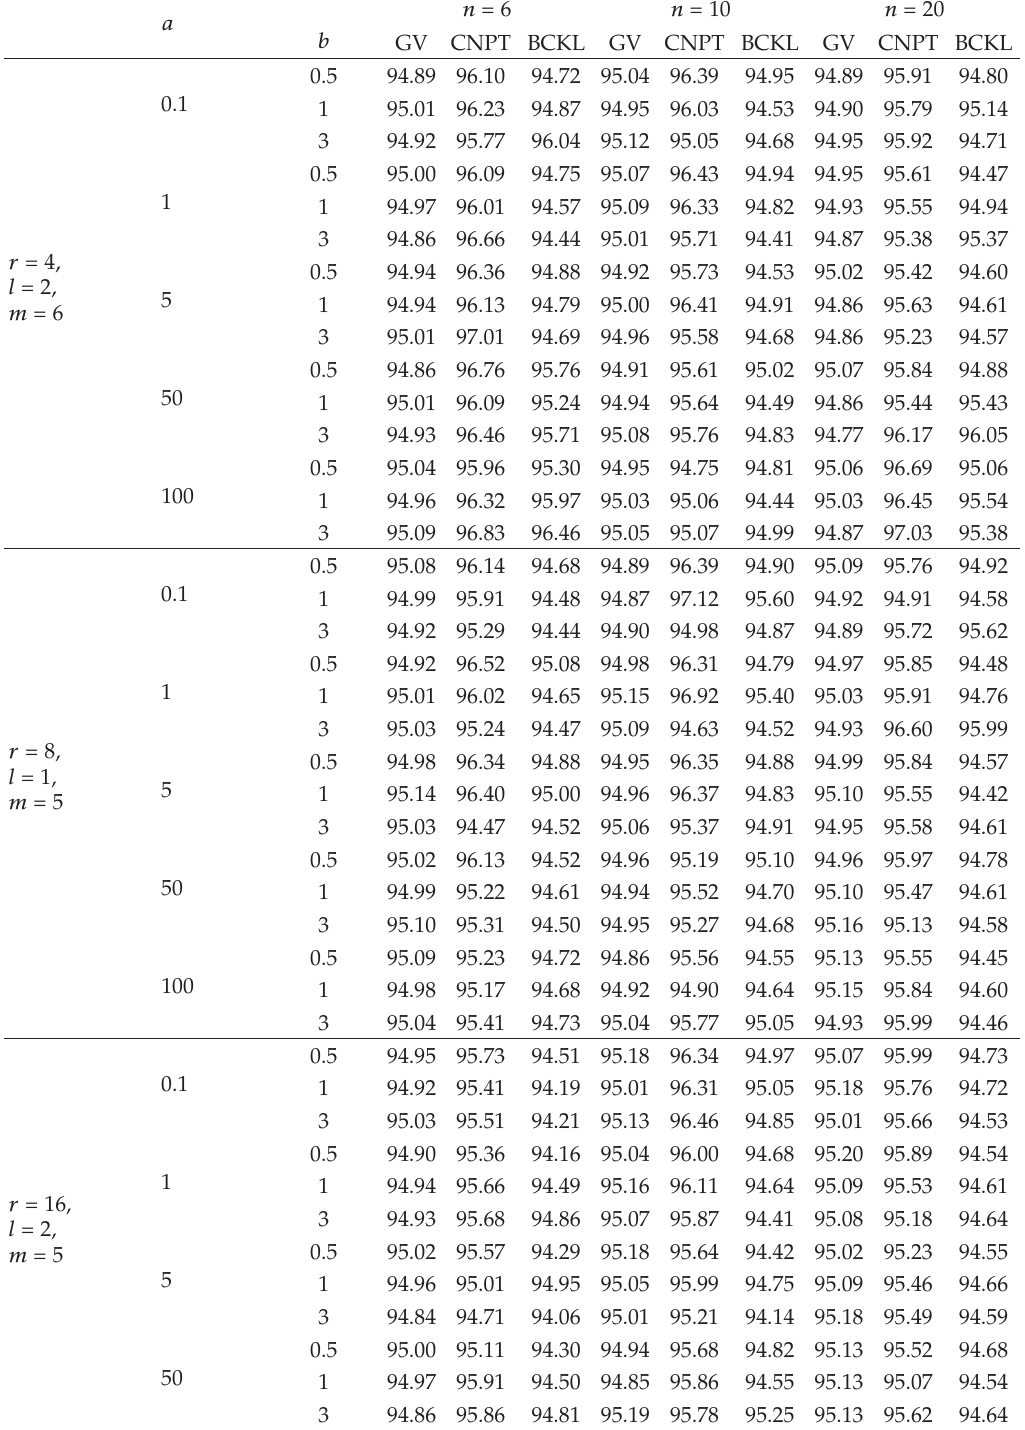
Table 3: Percentage simulated coverage probabilities of 95% UPL that contain at least l of m future observations at each of r locations from Weibull (cid:3) a, b (cid:4) distribution for sample sizes n (cid:5) 6, 10, 20 using GV, CNPT, and BCKL methods ∗